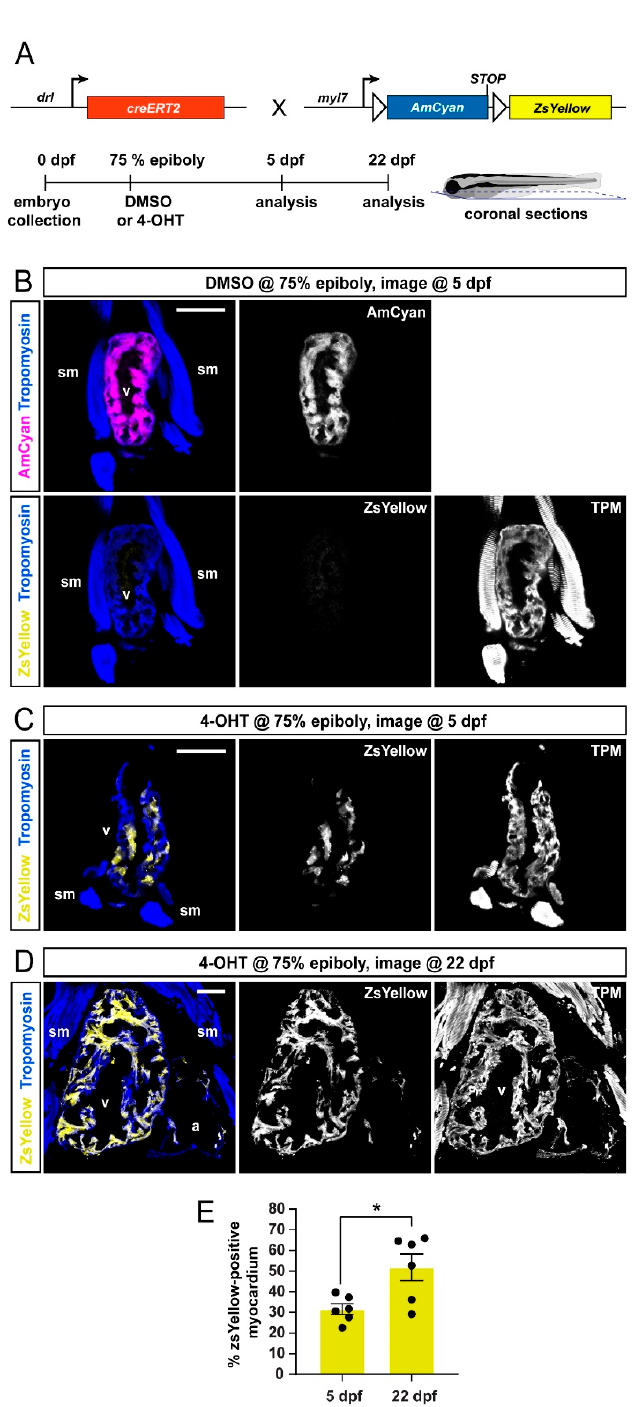
Figure 2. FHF lineage labeling persists during developmental stages. ( A ) Crossing scheme of used transgenes and timeline of experimental setup with 5 days post-fertilization (dpf) embryos and 22 dpf larvae longitudinally sectioned for heart analysis. ( B – D ) Confocal images of individual coronal sections, stained for pan-muscle Tropomyosin (blue, sm indicating skeletal muscles, v indicating ventricle, a indicating atrium). Embryos at 5 dpf ( B ), treated with DMSO (control, n = 4) at the 75% epiboly, show only myocardial AmCyan expression from myl7:Switch , while 4-OHT treatment ( C ) results in ZsYellow-expressing clones from drl:creERT2 activity, as also observed at 22 dpf ( D ). ( E ) Quantification of the ZsYellow–Tropomyosin double-positive cardiomyocytes of analyzed ventricles, two-tailed Student’s t -test, * p = 0.0149, 5 dpf n = 6; 22 dpf n = 6. Scale bar 50 µm.